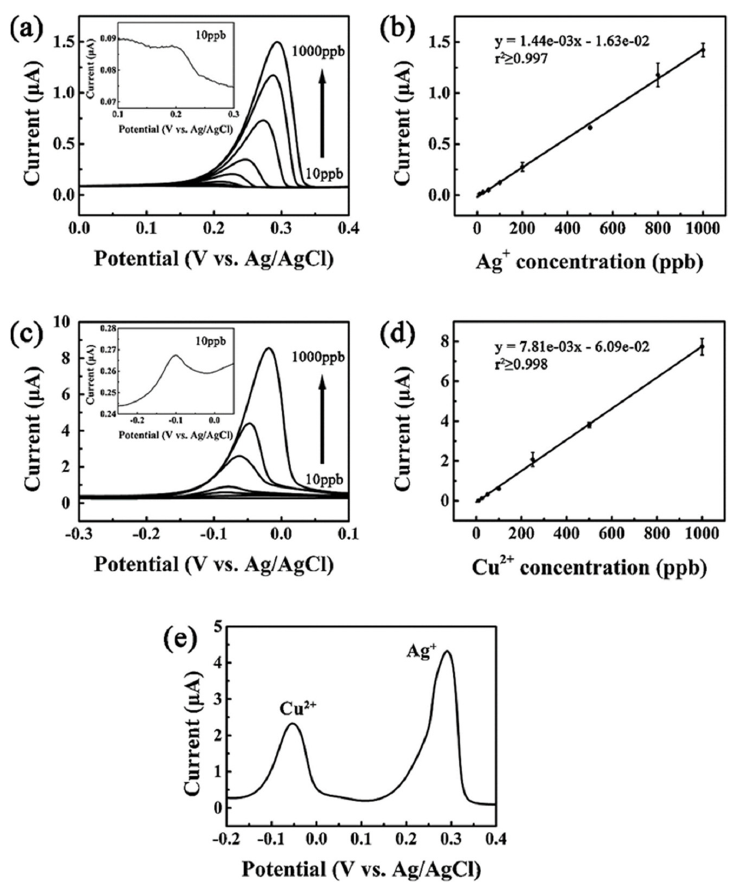
Figure 3. Anodic stripping voltammograms of ( a ) silver and ( c ) copper in heavy metal ion